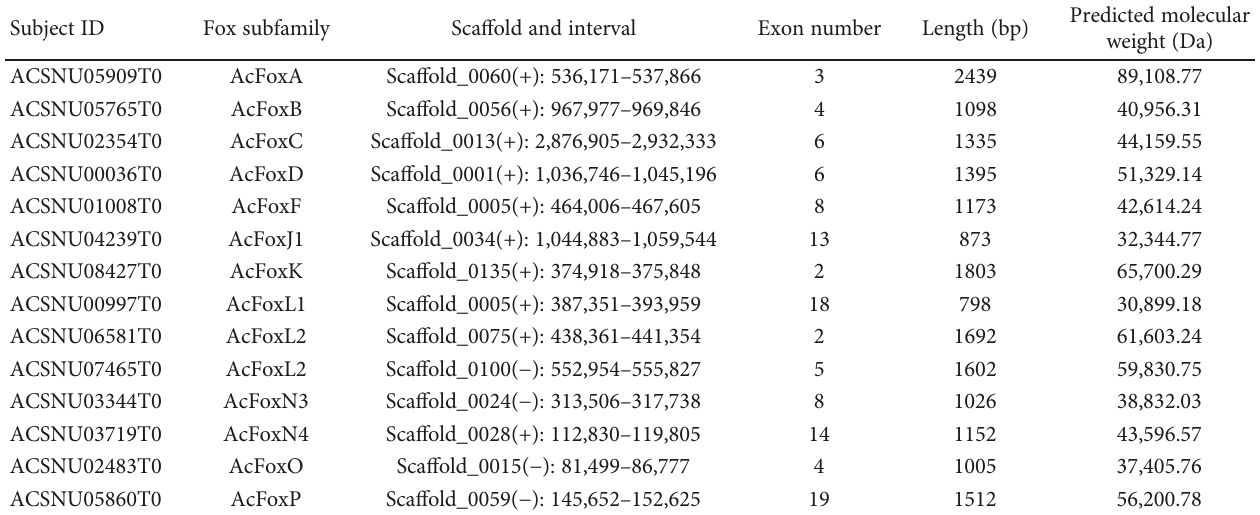
Table 1: Summary of Fox genes in the Apis